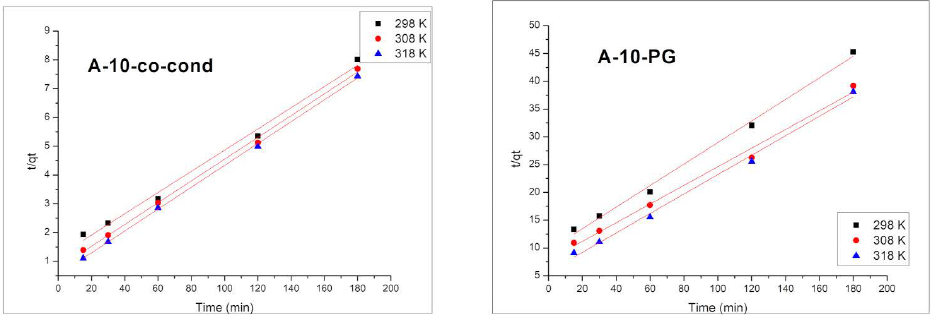
Figure 10. Pseudo-second order kinetic model for the A-10-co-cond ( left ) and A-10-PG ( right ) samples. Table 2. Kinetic parameters for Cr(VI) adsorption onto the A-10-co-cond and A-10-PG materials. Pseudo-First Order Kinetic T , K q e , exp , mg/g